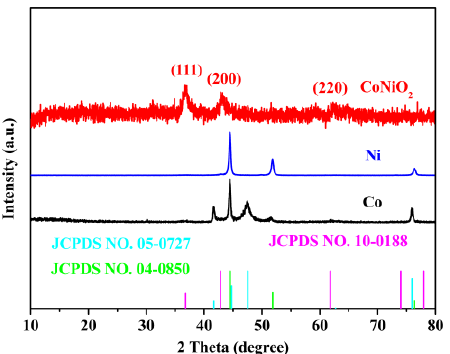
Figure 2. An XRD pattern showing the crystalline structure of CoNiO 2 , Ni and Co.